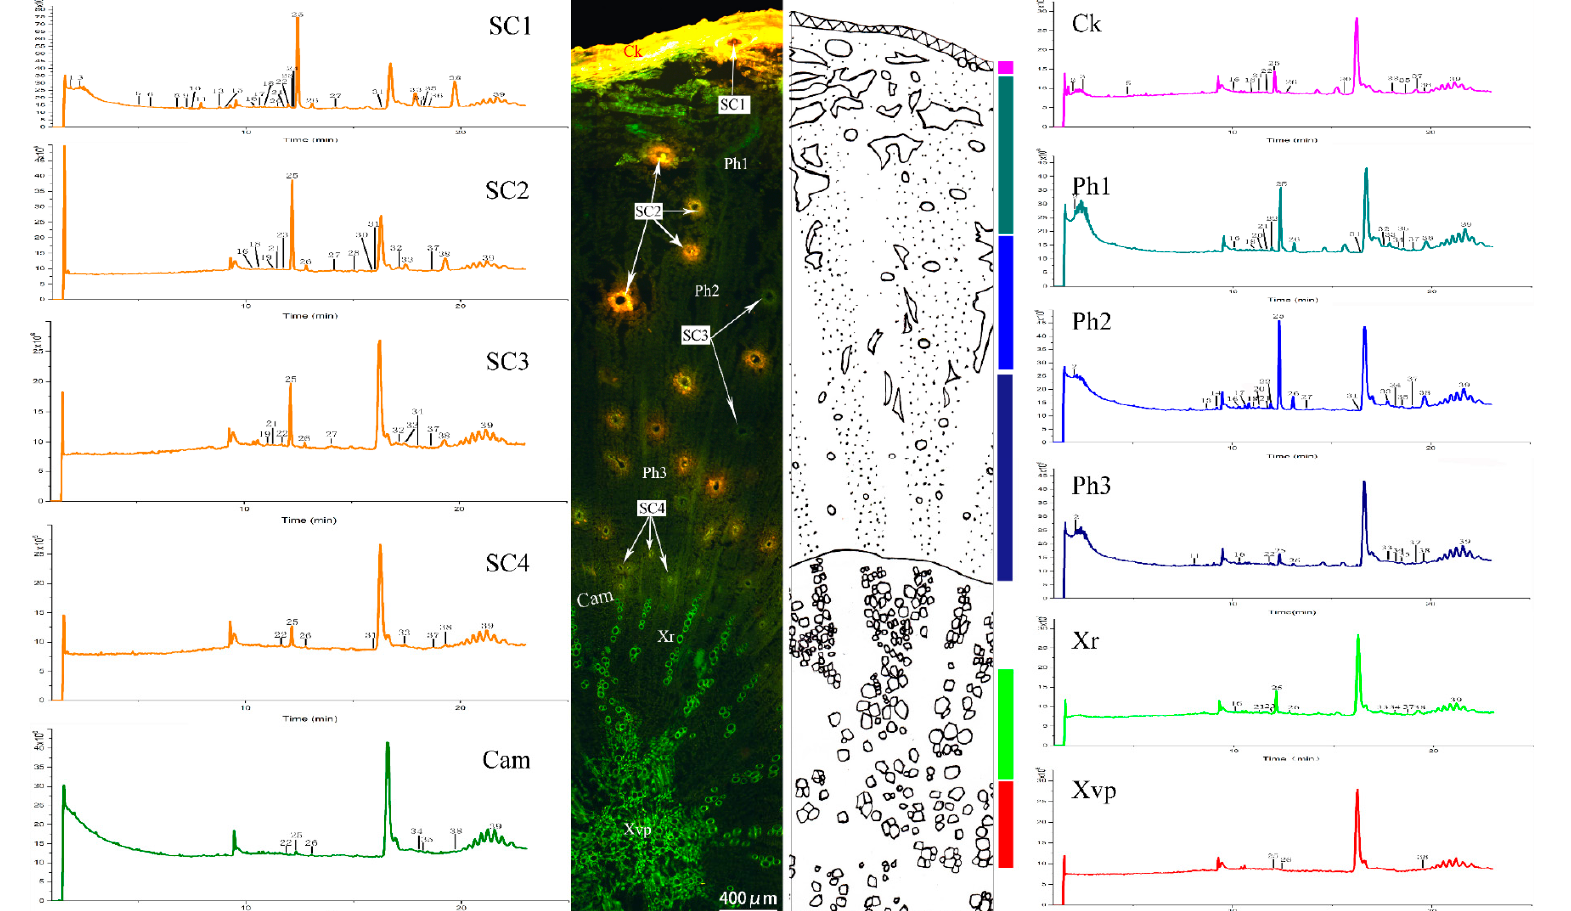
Figure 3. LC–MS base peak chromatograms of microdissected tissues from Ci Qianhu (Sample 8). The peak numbers referred to Table 1. SC1, secretory canals 1; SC2, secretory canals 2; SC3, secretory canals 3; SC4, secretory canals 4; Cam, cambium; Ck, cork; Ph1, secondary phloem1; Ph2, secondary phloem2; Ph3, secondary phloem3; Xr, xylem ray; Xvp, xylem vessels and parenchyma cells.